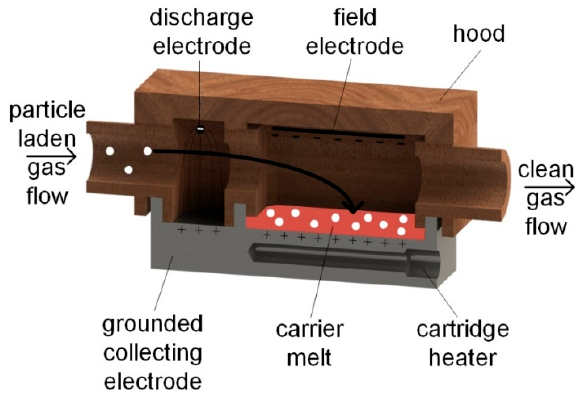
Figure 2. Schematic cross-section of the melt electrostatic precipitator.